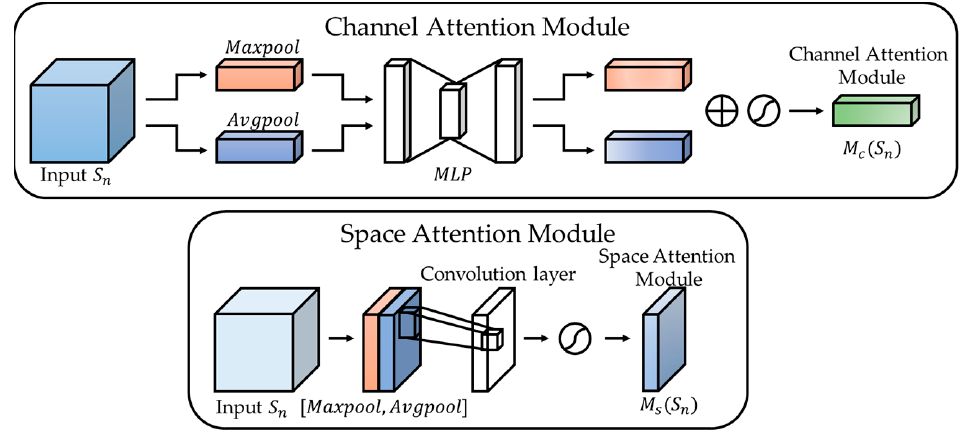
Figure 14. A tt ention modules.